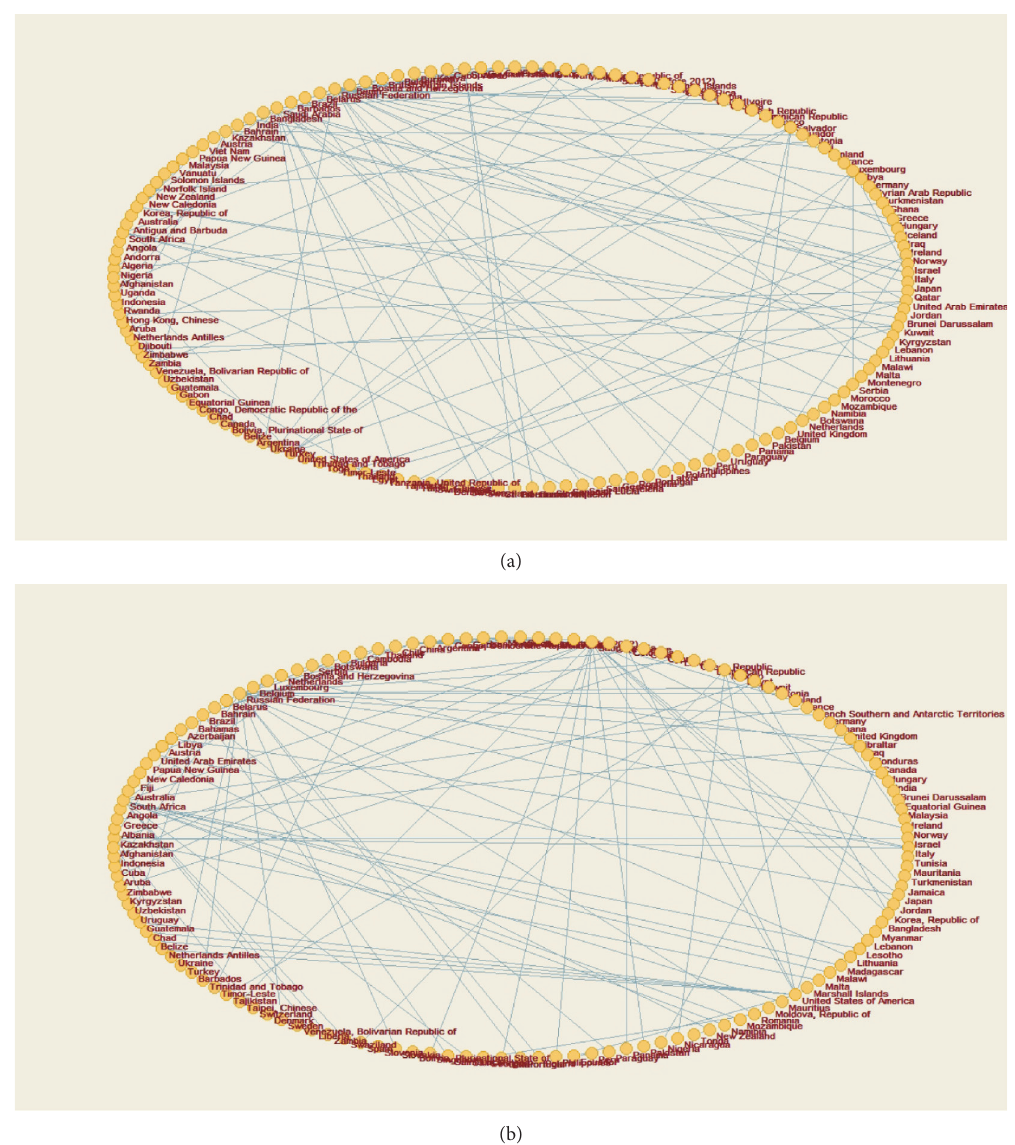
Figure 7: Minimum spanning tree of the global crude oil trading network before optimization: (a) 2010; (b) 2016.